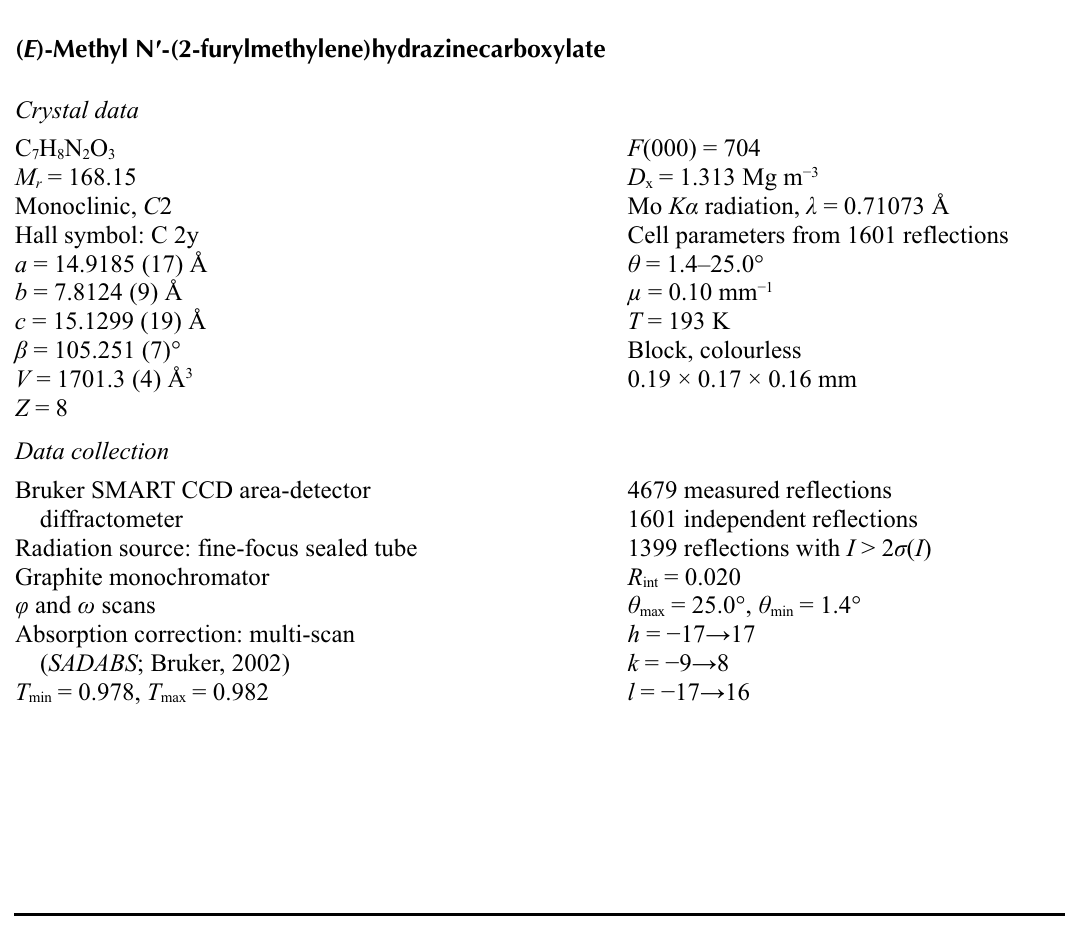
Crystal packing of the title compound. Hydrogen bonds are shown as dashed